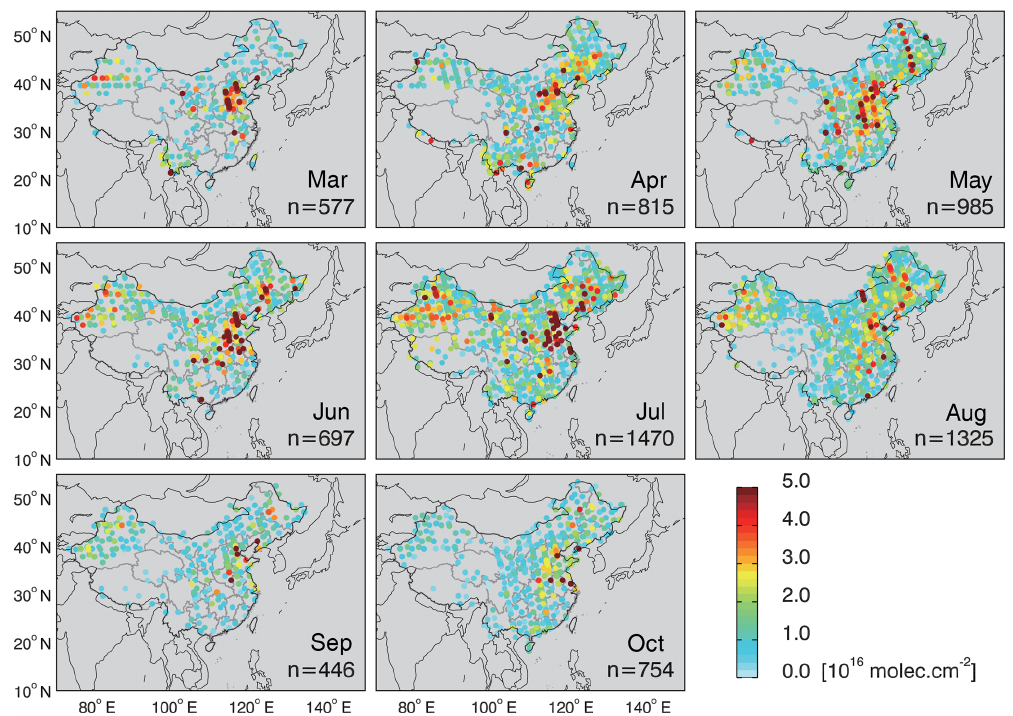
Figure 2. TES observations of NH 3 column concentration over China from March to October in the years 2005–2010. Each point represents a TES observation with a footprint resolution of 5km × 8km. Values inset are number ( n ) of valid observations for assimilation in each